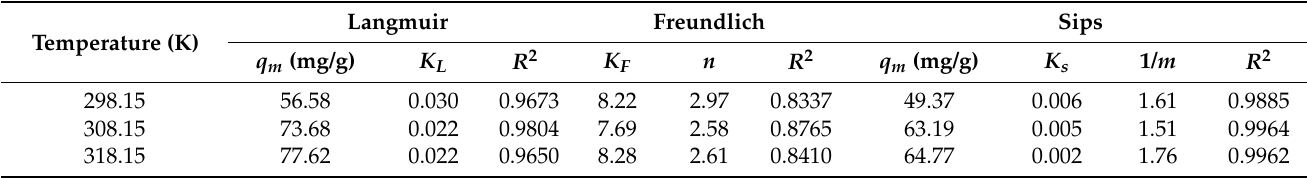
Table 3. Adsorption isothermal model parameters.